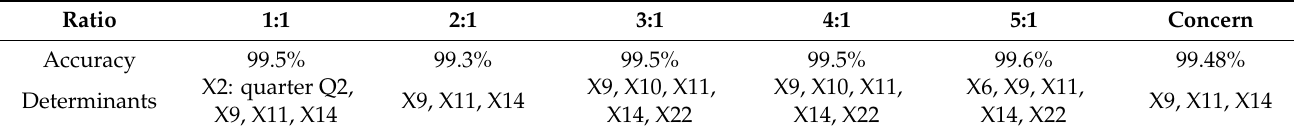
Table 22. The statistical results of LR analysis of samples in the five ratio groups from Tables